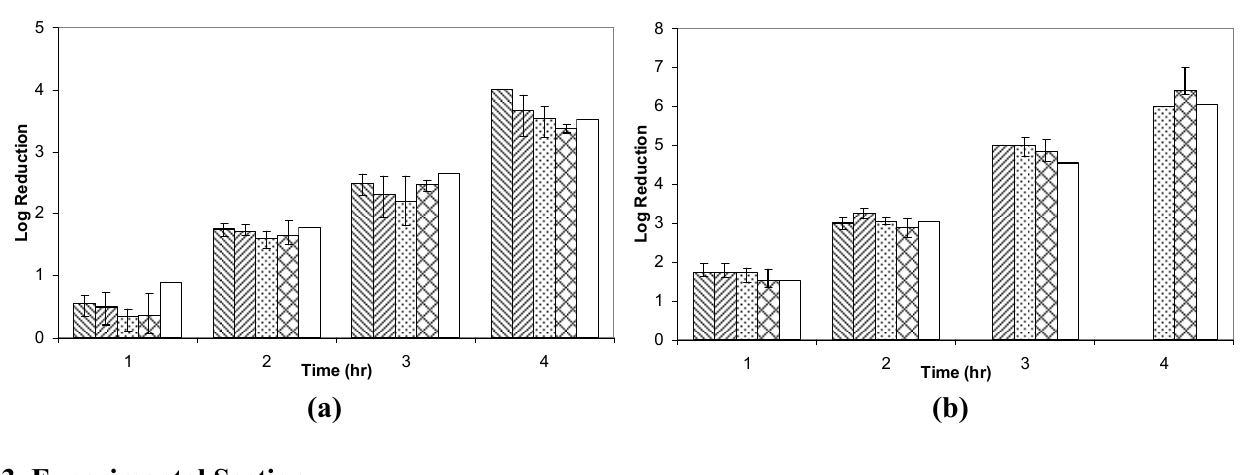
Figure 3. Comparison of the experimental results of 0.9% dialdehyde starch aqueous suspension against E. coli (a) and 0.6% dialdehdye starch aqueous suspension against S. aureus (b) in various initial bacterial concentrations with the calculated results from Equation